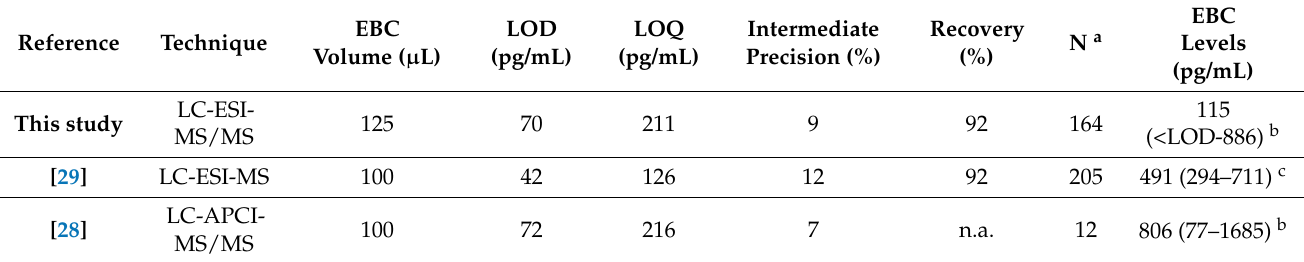
Table 3. Descriptions of the analytical methods previously developed to analyze MDA in EBC with DNPH derivatization.